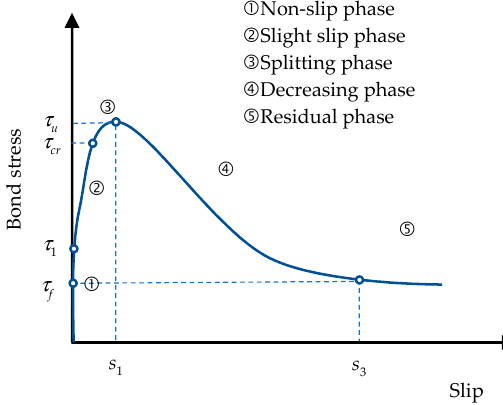
Figure 9. Typical local bond stress–slip curve.